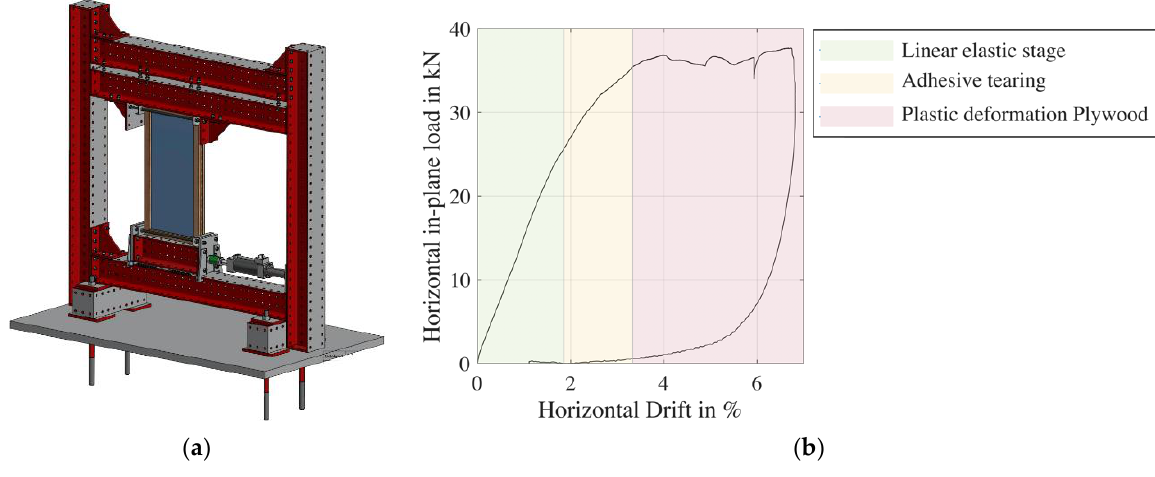
Figure 3. In-plane test on the standalone window: ( a ) test set-up, ( b ) obtained capacity curve.